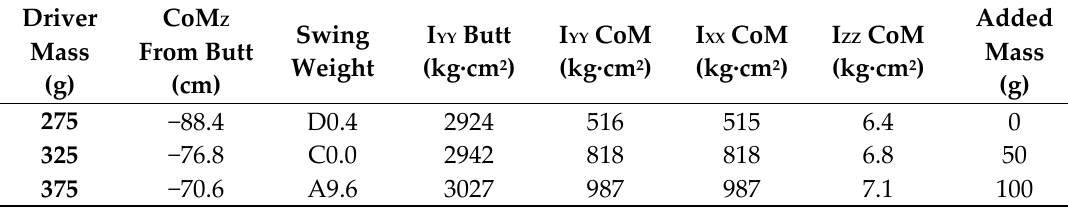
Table 1. Golf club inertial properties relative to a shaft-based reference frame. At impact, Z points down the shaft, X points down the target line, and Y is according to the right-hand